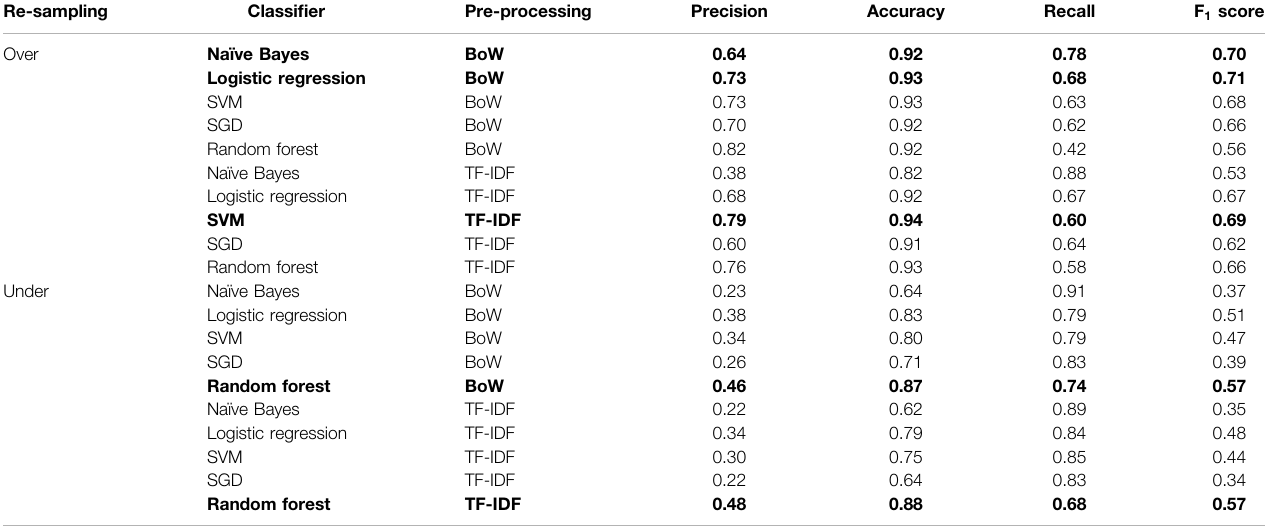
TABLE 4 | Evaluation metrics (precision, accuracy, recall, and F 1 score) for all the classi fi ers, considering only textual feature selection. Bold values represent the highest performance results based on the F 1 score. We used different metrics for evaluating ML classi fi ers with BoW and with TF-IDF. As shown in this table, the logistic regressionclassi fi erperformedbetterwithF 1 score0.71comparedtootherclassi fi ersusingBoWincaseofover-sampleddata.Similarly,theSVMclassi fi erperformedbetter using TF-IDF in case of over-sampled data. Due to the small size of the dataset, the under-sampling technique was not well-suited for the classi fi ers, as the results showed that the classi fi ers performed very poorly.